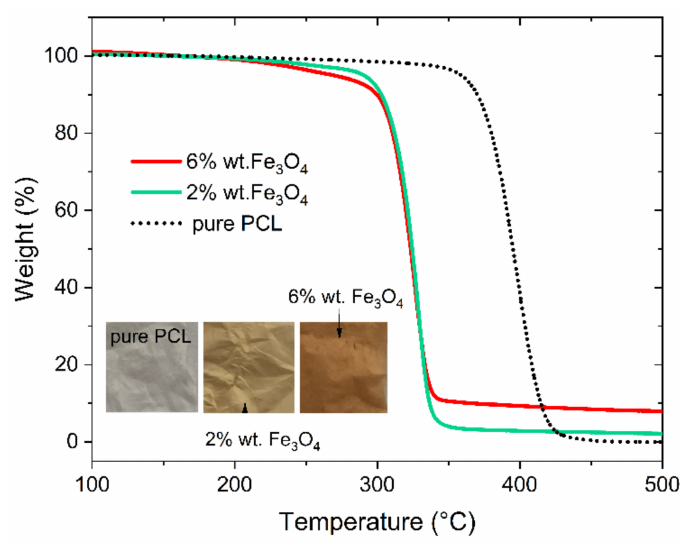
Figure 1. TGA curves for the pure PCL and magnetic electrospun